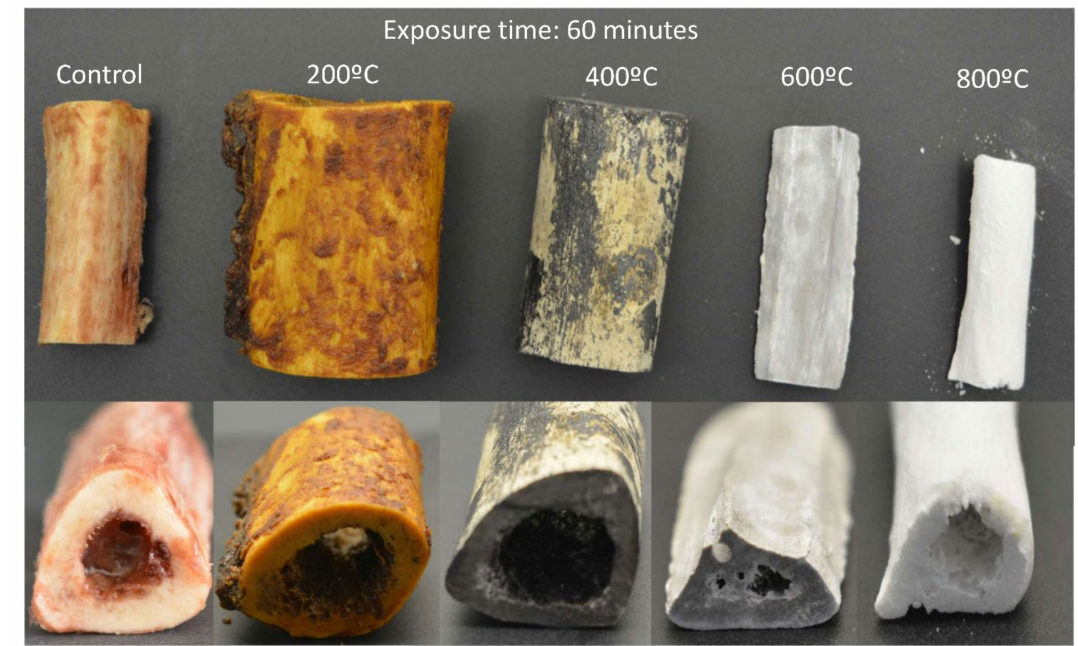
Figure 2. Color changes in bones after exposure at di ff erent temperatures (°C) for 60 min. From left to right: tibia, femur, tibia, ulna, and